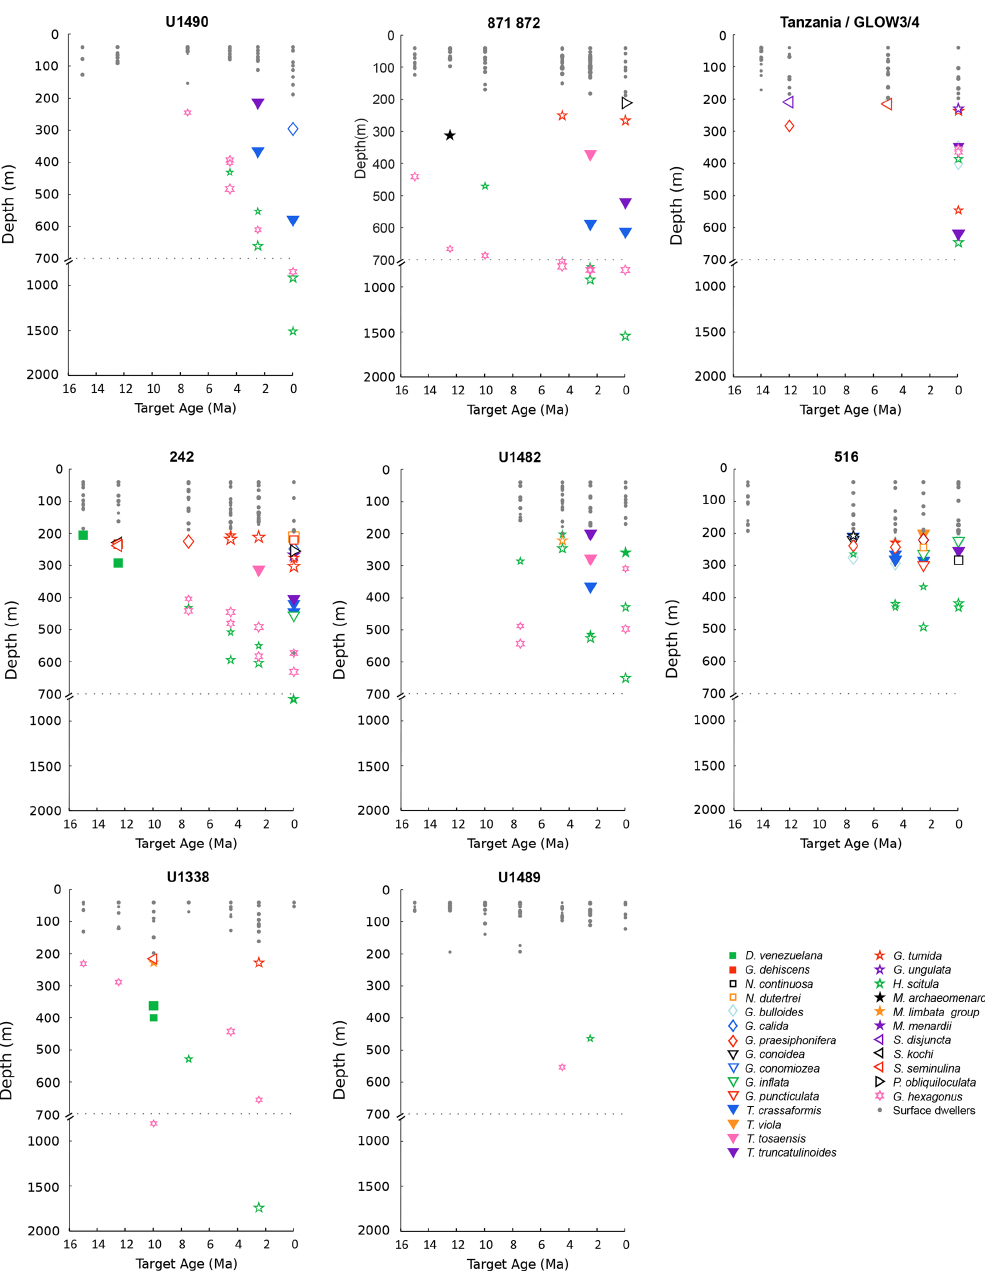
Figure 1. Depth habitat reconstructions for middle Miocene to present planktonic foraminiferal species at the investigated sites. Surface dwellers (species living at depths shallower than 200m) are indicated with a grey dot, and deeper species are indicated with coloured symbols. The relative size of the symbols represents the size fractions of the sample. Reproduced from Boscolo-Galazzo et al.